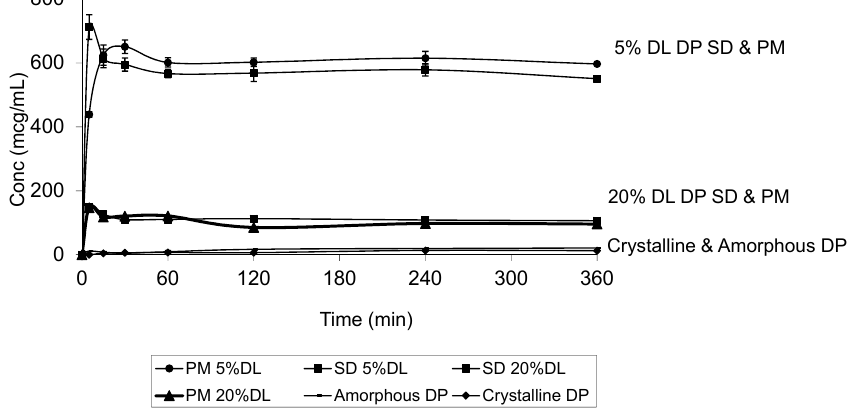
Figure 10. Dissolution profile of crystalline and amorphous DP, DP-PVPK30 solid dispersion (SD) and physical mixture (PM) at 5% and 20% drug loading (DL) confirming that the dissolution is dependent on the polymer concentration and not the drug form.